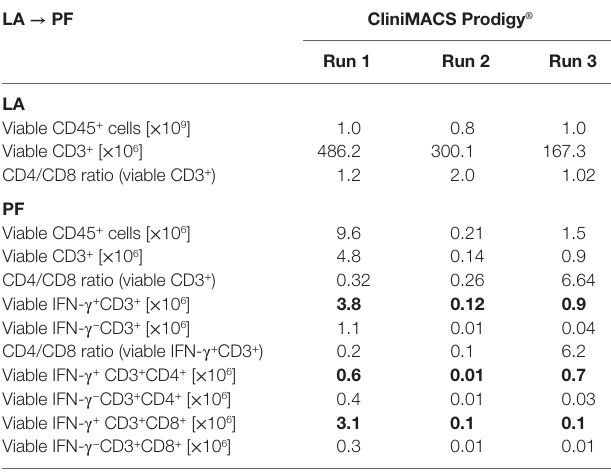
tABLe 1 | Comparison of flow cytometric cell counts and subset ratios for three clinical-scale CliniMACs Prodigy ® procedures using the CliniMACs CCs ® protocol for the manufacture of CMV-specific t-cells. LA →